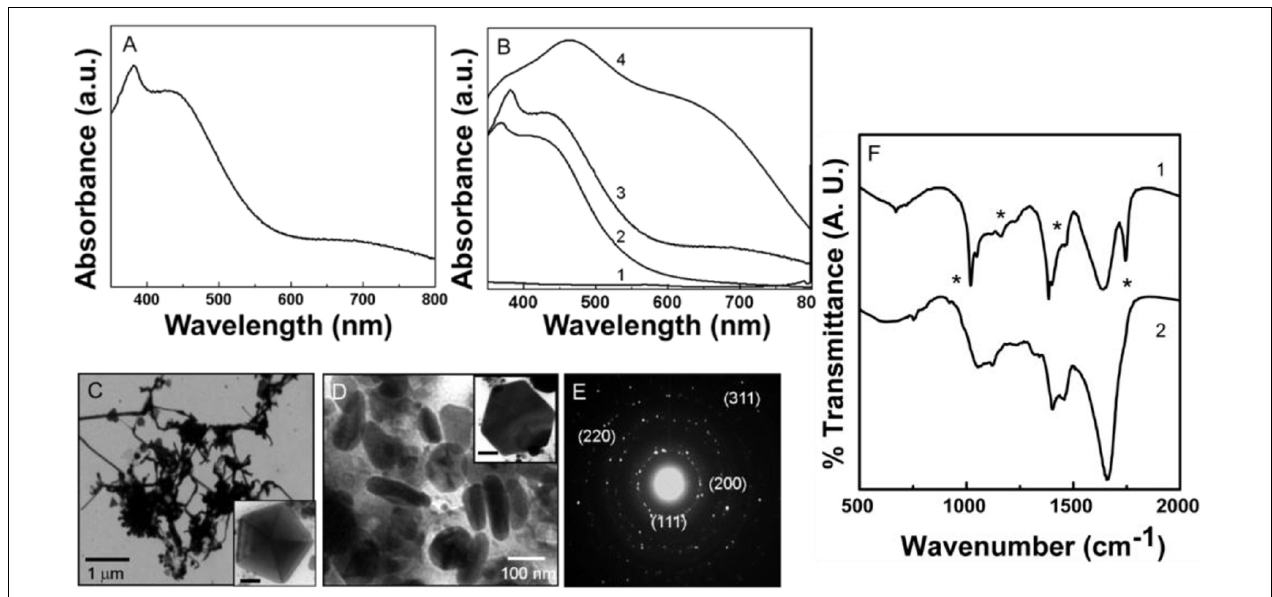
FIGURE 4 | Uv-Vis spectroscopy, transmission electron microscopy (TEM), and Fourier transformed infrared spectroscopy (FTIR) analysis of biologically synthesized Py-AgNPs. (A) Uv-Vis spectra of Py-AgNPs showing the presence of the transverse and longitudinal SPR bands. (B) Py-AgNPs formation kinetics investigated by Uv-Vis absorption spectroscopy. Number 1-3 corresponds to 15, 30, and 60 min of reaction. (C,D) TEM images of Py-AgNPs were synthesized after 60 min of reaction. Inset in panels (C,D) show pentagonal and hexagonal population of nanoparticles. Scale bar in panels (C,D) is 50 nm. (E) SAED pattern obtained from Py-AgNPs showing crystalline nature of nanoparticles. (F) FTIR spectrum obtained from pyoverdine- silver ions reaction mixture before (1) and after (2) the formation of Py-AgNPs. Asterisks indicate the bond vibrations from the pyocyanin spectrum that are affected after NPs